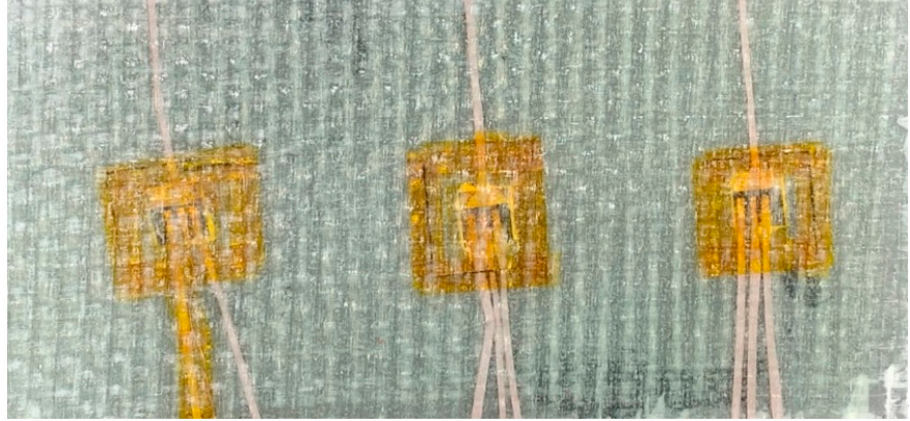
Figure 5. Embedded sensor in glass fiber-reinforced composite panel.